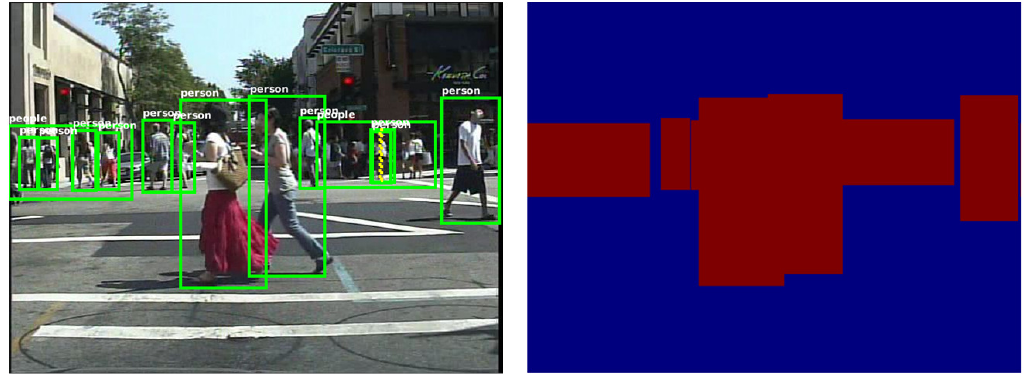
Figure 3. Labels of the dataset ( left ) and the transformed one ( right ). In the right picture, values in the red area are set to one, in the blue area to